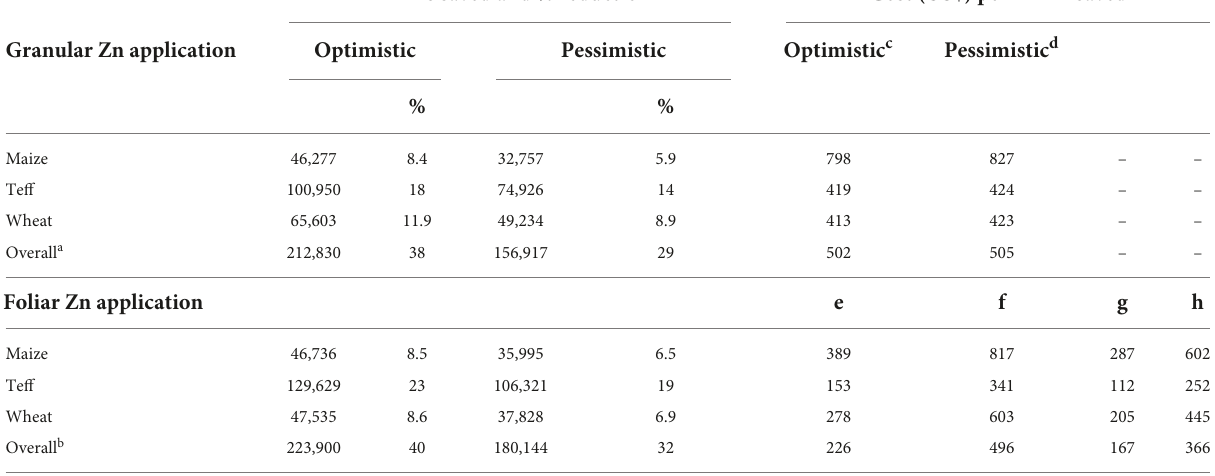
TABLE 2 DALYs saved and cost-effectiveness of ZAB through granular and foliar Zn fertilizer in Ethiopia under “optimistic” and “pessimistic” scenarios of adoption rates. DALYs saved and % reduction